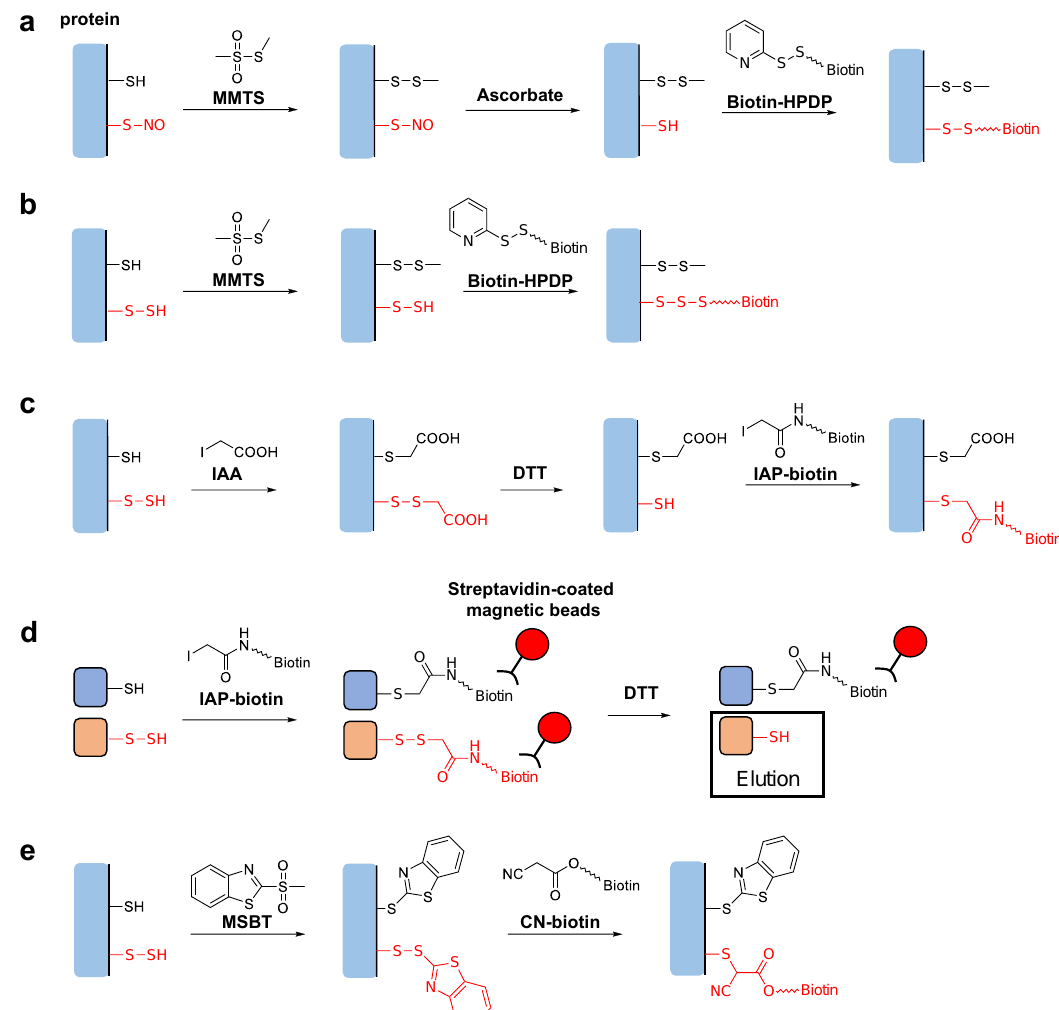
Figure 1. ( a ) Proposed mechanism of the tag-switch technique for the detection of nitrosothiol modification in proteins. ( b – d ) Proposed mechanisms of tag-switch techniques for the detection of cysteine per/polysulfides in proteins. The target persulfide groups are switched to biotin-linked modifications derived from ( b ) biotin-HPDP and ( c ) IAP-biotin for further analyses. ( d ) To isolate persulfurized proteins, the biotin-linked disulfides derived from IAP-biotin can be selectively reduced by DTT and eluted from the streptavidin-coated magnetic beads. ( e ) CN-biotin can also be used to switch the target persulfide groups to biotin-linked modifications for further